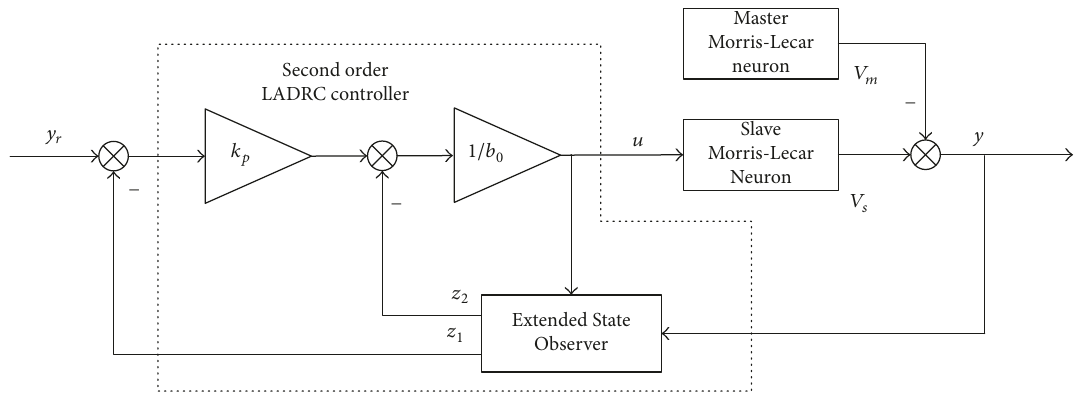
Figure 2: Synchronization structure of Morris-Lecar neurons by